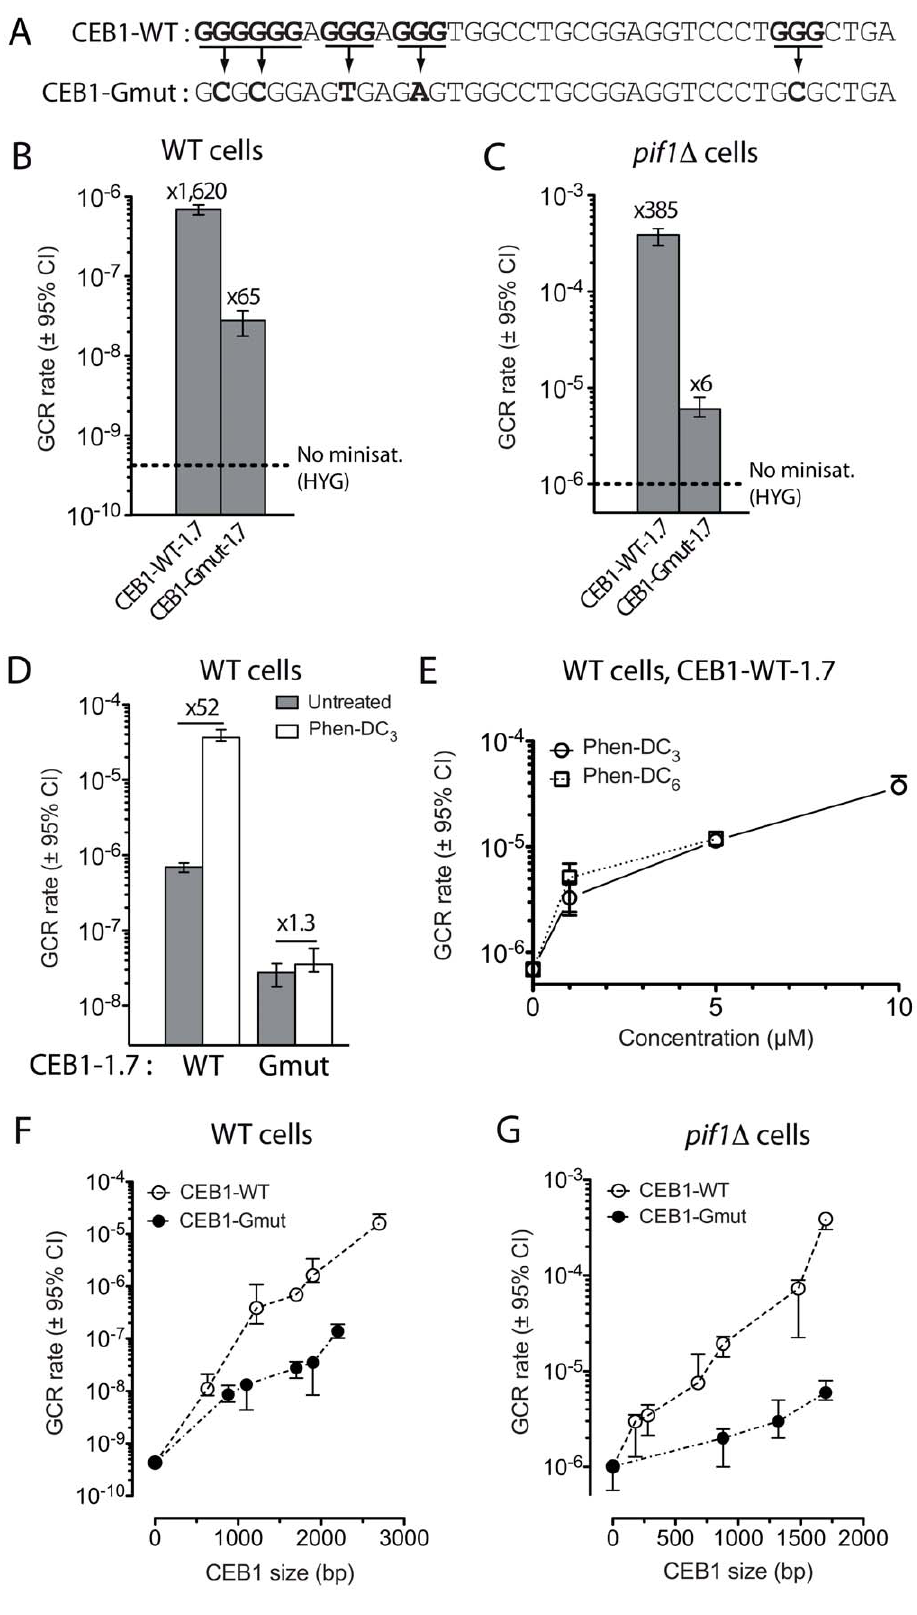
Figure 2. Size-dependent minisatellite fragility is aggravated by its ability to form G-quadruplexes, especially in G-quadruplex- stabilizing conditions. (A) Sequence of the CEB1-WT and CEB1-Gmut motifs used in this study [16,18]. G-tracts potentially involved in the G- quadruplex formation are in bold and underlined. Single nucleotide mutations are depicted in bold. (B) GCR rates in WT cells bearing either CEB1-WT-